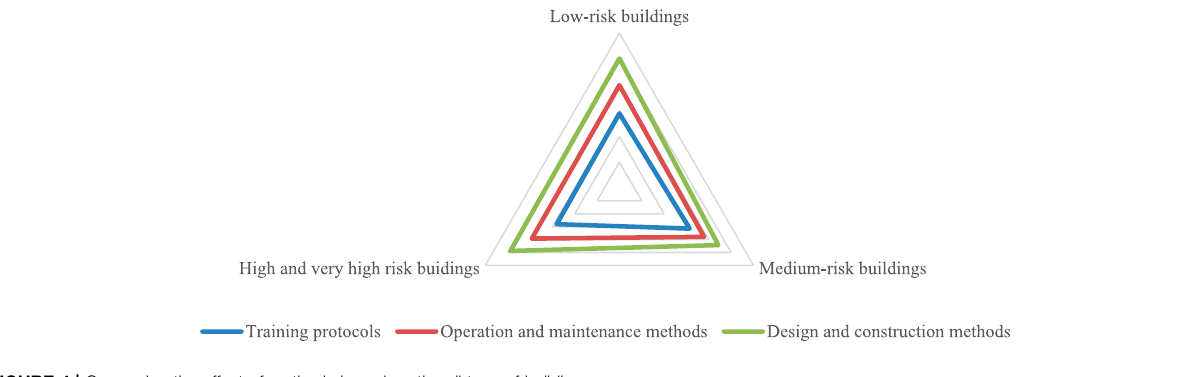
FIGURE 4 | Comparing the effect of methods based on the all type of buildings.